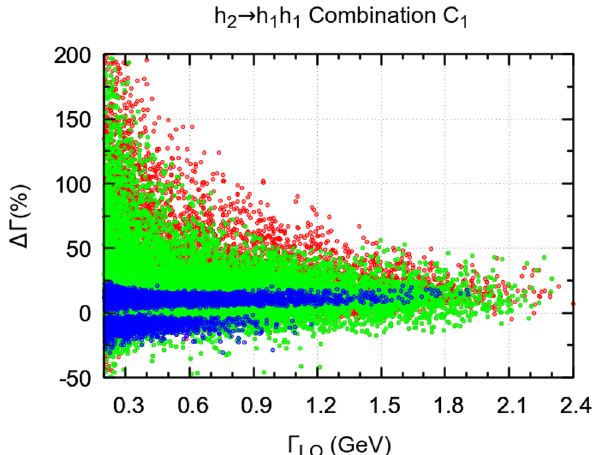
Figure 6 . Identical to figure 5 top left, except that blue/black points are included, satisfying all constraints and, additionally, | λ i | < 2 (see text for